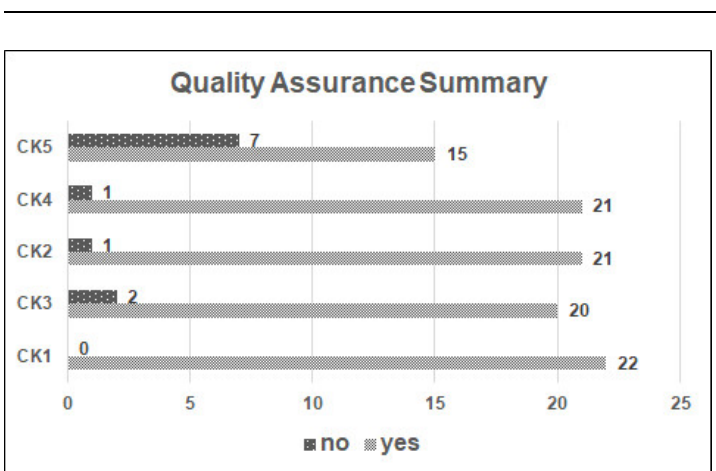
Figure 2. Quality Assurance